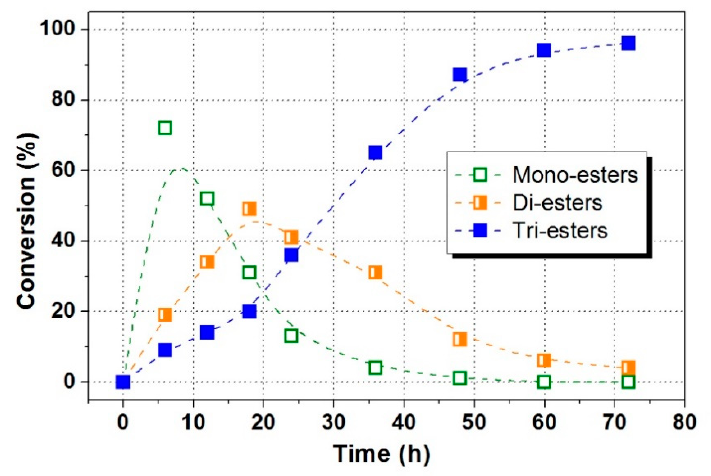
Figure 6. The formation of mono ‐ , di ‐ , and tri ‐ esters during enzymatic esterification.